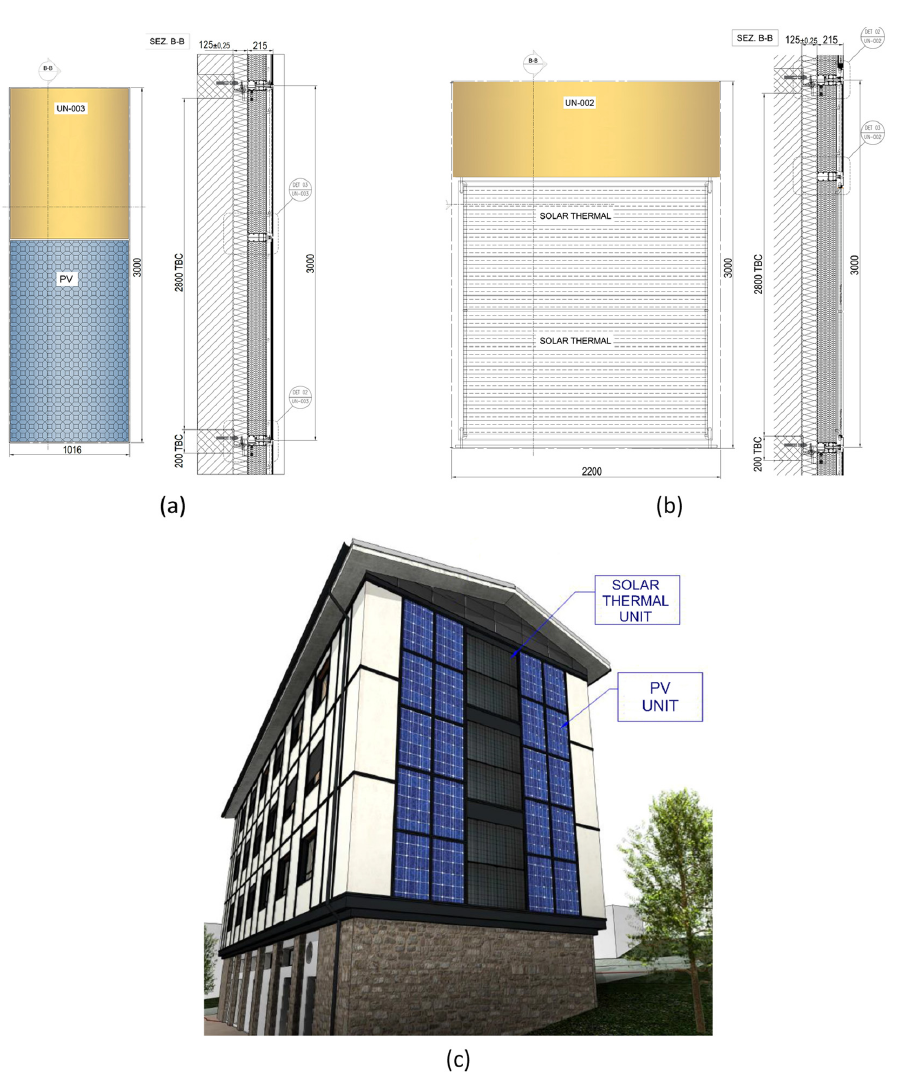
Figure 10. ( a ) PV unit cross section; ( b ) solar thermal unit; ( c ) photovoltaic and solar thermal energy installation (measurements in mm). installation (measurements in